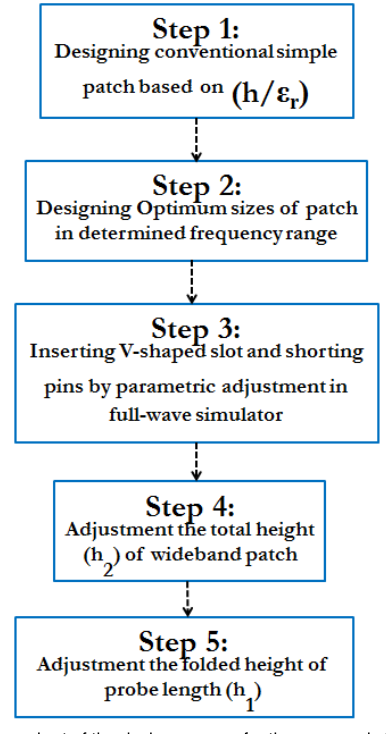
FIGURE 3 . Flow chart of the design process for the proposed